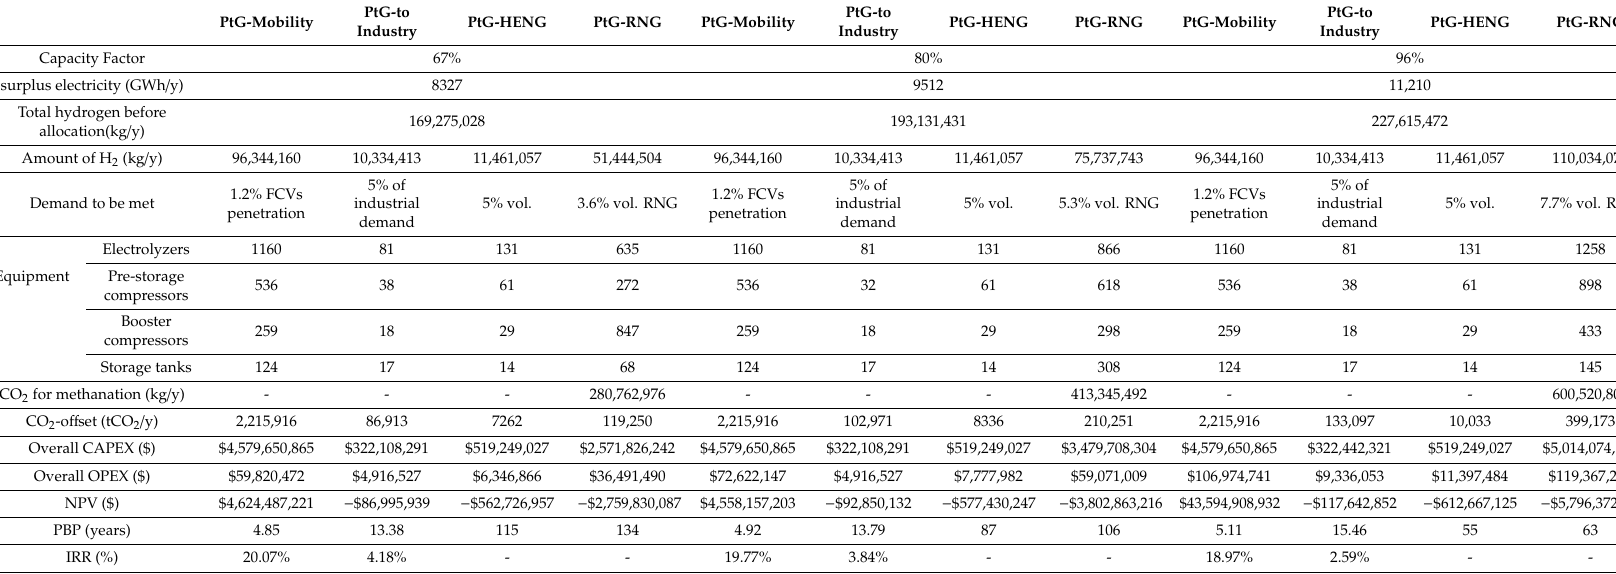
Table 7. Allocation of hydrogen produced via PtG concept at three capacity factors (67%, 80%, and 96%) for the four PtG pathways. PtG-Mobility PtG-to Industry PtG-HENG PtG-RNG PtG-Mobility PtG-to Industry PtG-HENG PtG-RNG PtG-Mobility PtG-to Industry PtG-HENG